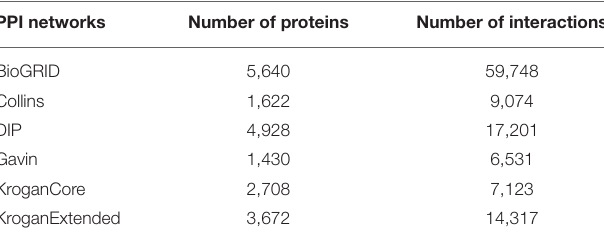
TABLE 1 | The basic statistical information of different datasets.